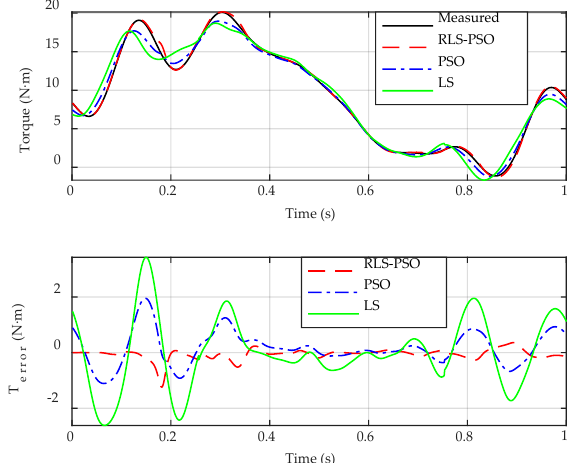
Figure 9. Measured torque, identified torque, and T error .